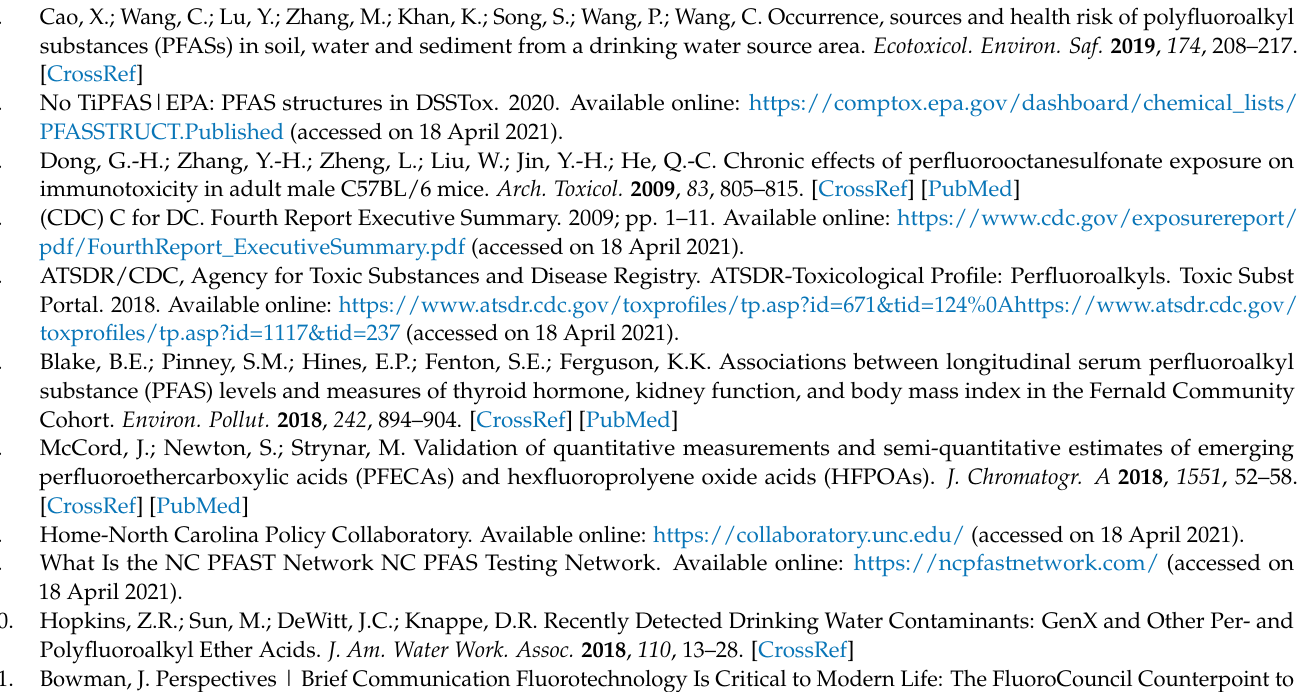
Table S8: Mean ( ± SD) absolute number of splenic B and natural killer cells from male and female C57BL/6 mice orally exposed to PFMOAA, PFMOPrA or PFMOBA for 30